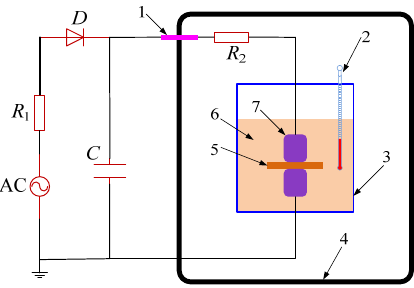
Figure 1. Breakdown system for oil ‐ impregnated paper under different temperatures.